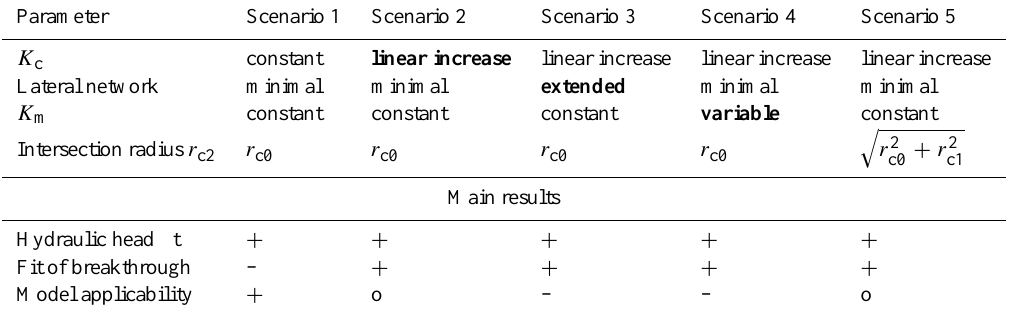
Table 3. Specifics of the different scenarios. The bold writing indicates the parameter that is analysed in the respective scenario. The results are indicated by comparative markers. “ + ” means good, “o” means average and “–” means bad compared to the other scenarios. Details to the scenarios and results evaluation can be found in Sect.